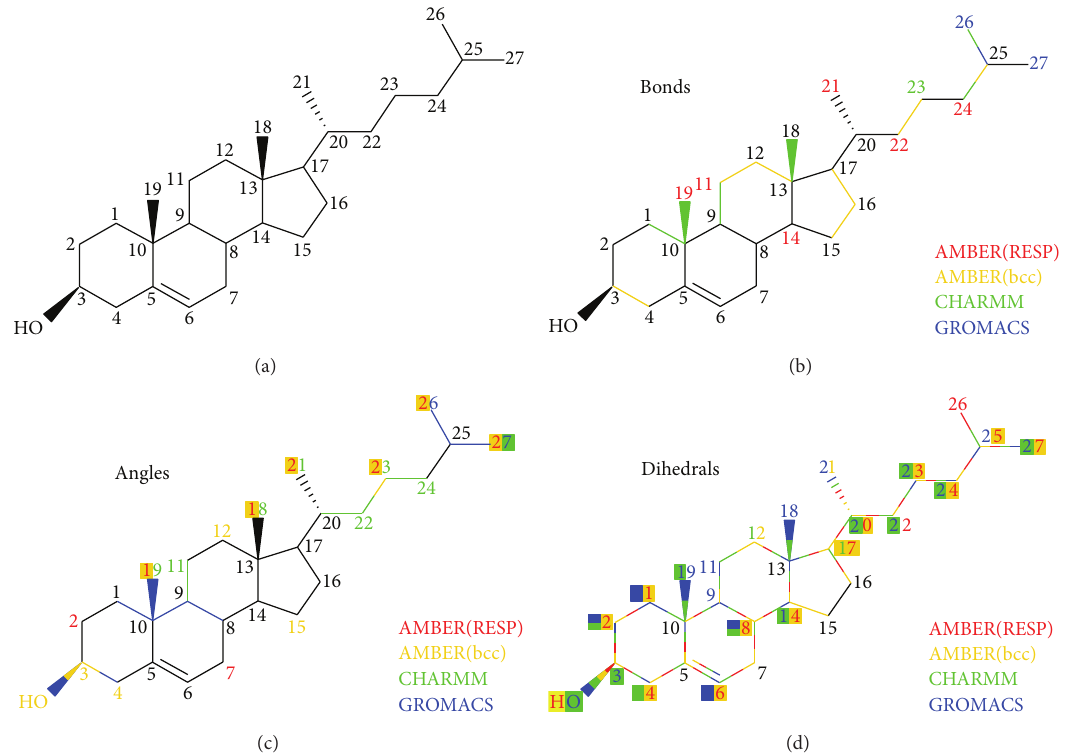
Figure 1: Principal component analysis (PCA) regarding 250 structural snapshots of cholesterol sampled over 5ns of molecular dynamics (MD) simulations using common force fields. (a) Nomenclature of 3 𝛽 -hydroxy cholesterol (numbering restricted to carbon atoms). (b) PCA of bonds (from a total of 77). (c) PCA of angles (157 angles in total). (d) PCA of dihedrals (259 dihedrals all in all). Color-coded are the top- ranked 10% bonds/angles/dihedrals based on a selection of PCs recovering 90% of the original data set. Different colors represent different force fields and involve C–H bonds if applied to